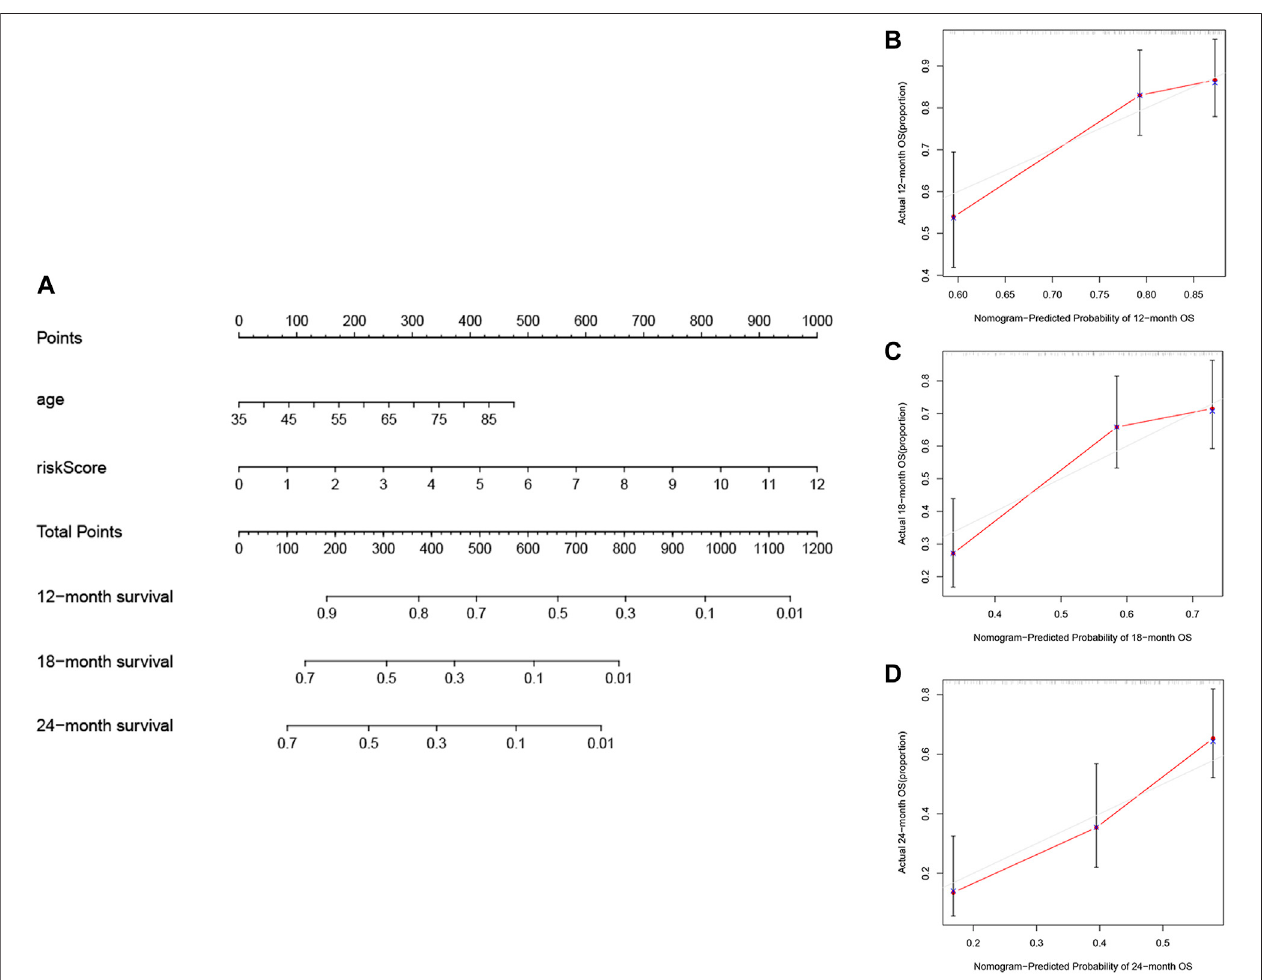
FIGURE 7 | Construction and validation of the nomogram. (A) Prognostic nomogram based on the risk score using the prognostic FRLs signature and the age to predict 12-, 18-, and 24-month survival in patients with PAAD. Calibration curves corrected for deviations in agreement between the predicted and observed survival rates at (B) 12, (C) 18 and (D) 24-months.